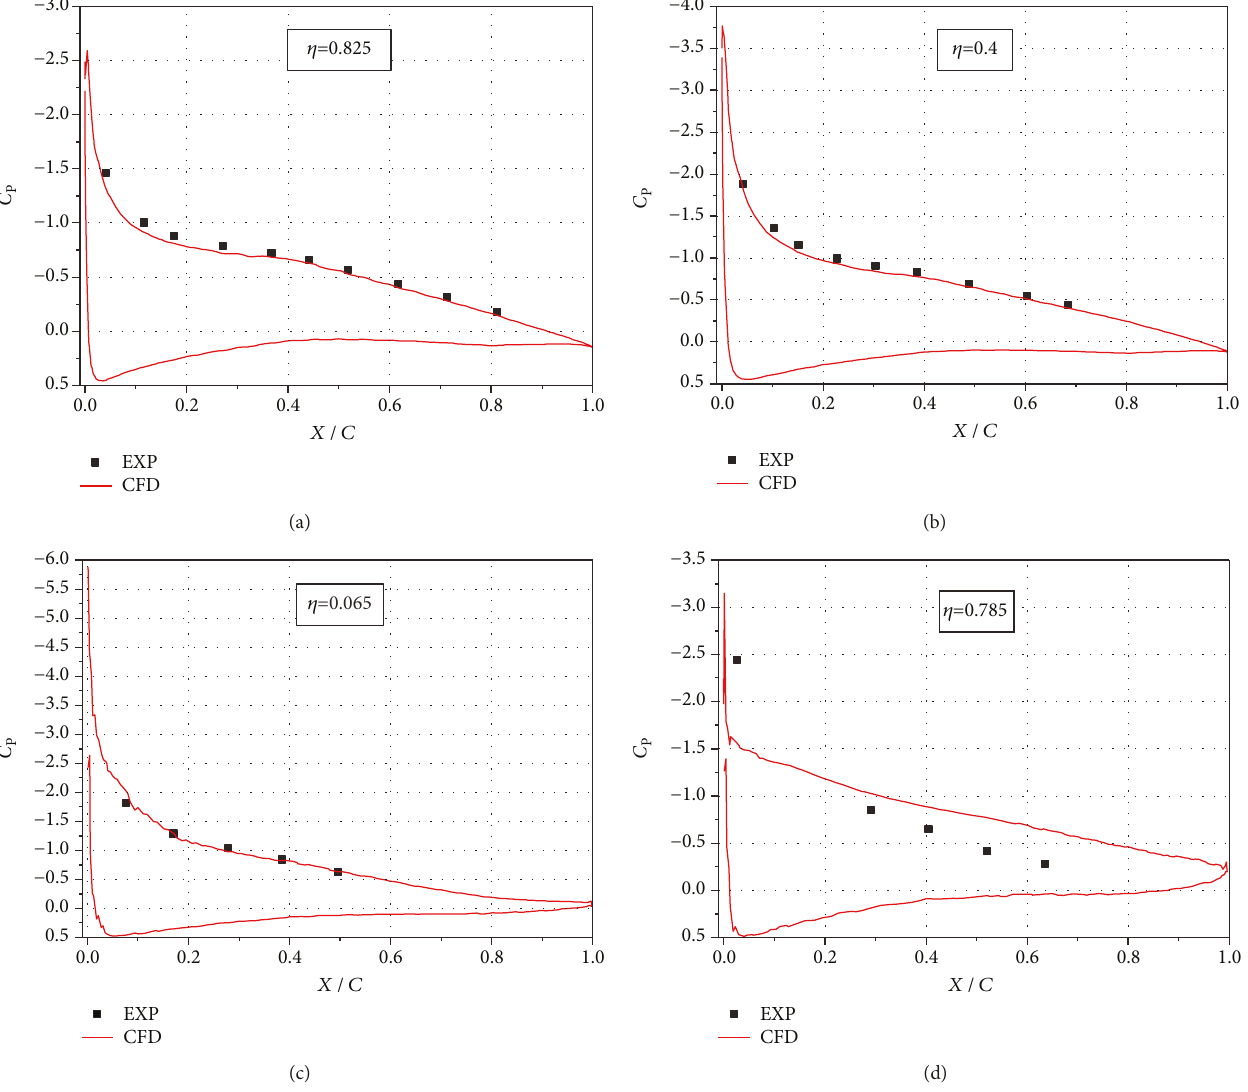
Figure 6: Pressure coe ffi cient of four stations ( η = 0 285 , 0.4, 0.65, and 0.785) at an angle of attack 12 ° .